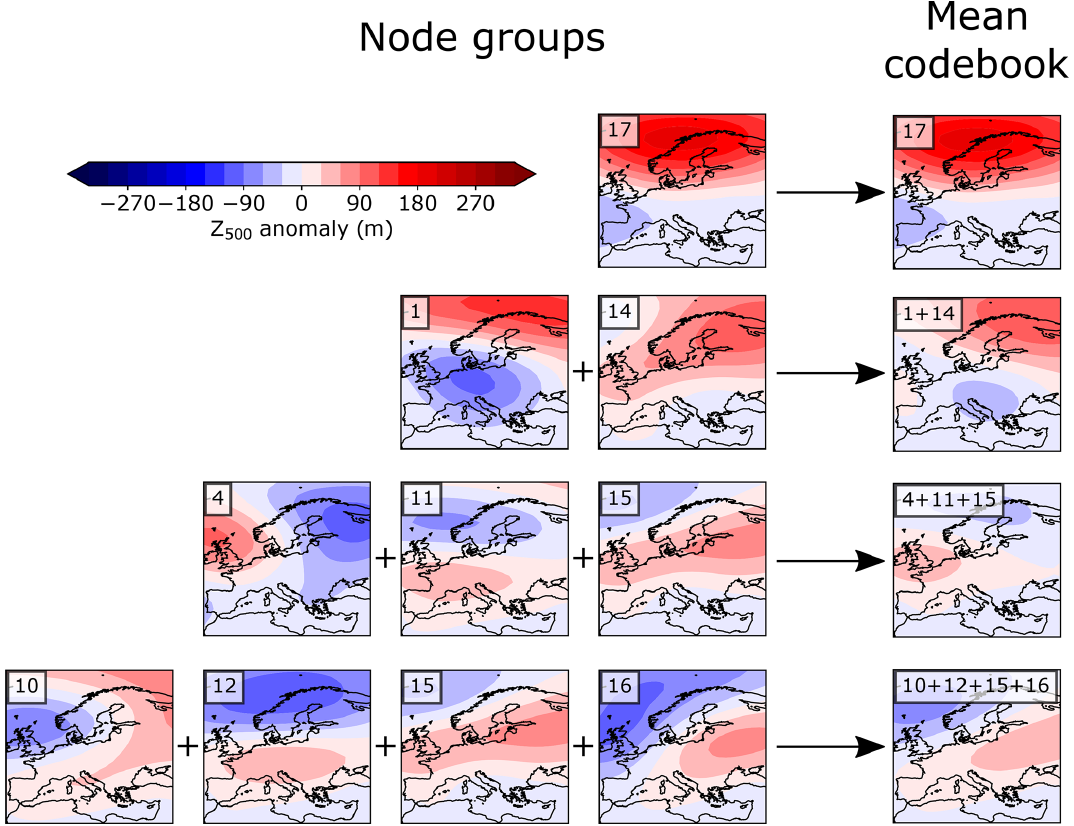
Figure 4. Examples of four blocked node groups identified by the SOM-BI described in Sect. 2.5 averaged to form mean codebooks. Shown here for Z 500 in the optimized case of 20 nodes. There are 114 blocked node groups in